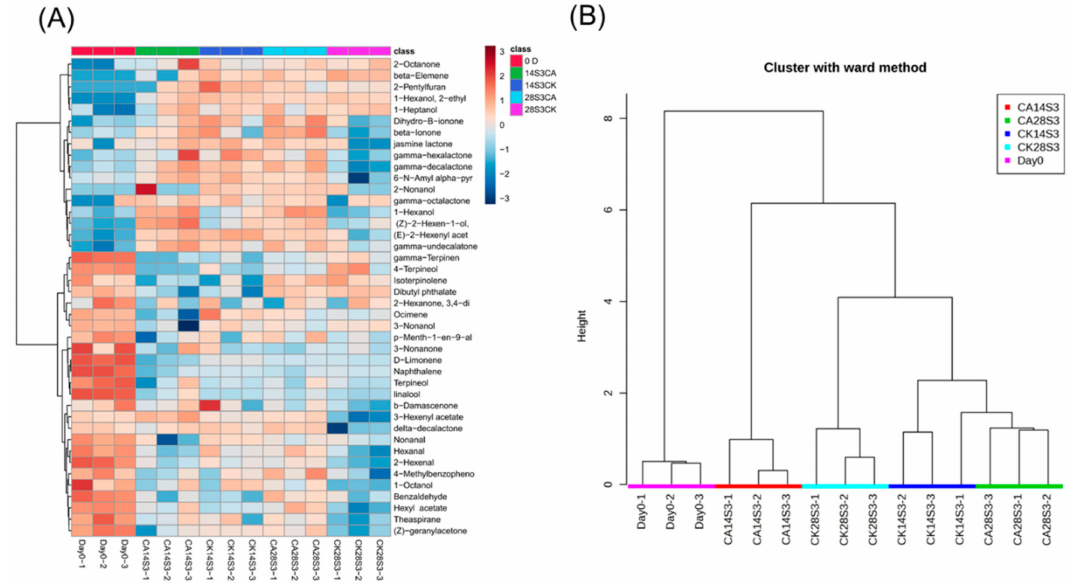
Figure 3. Cluster analysis of peach fruit volatiles during shelf-days after cold storage. ( A ) Heatmap of the peach fruit volatiles; ( B ) Cluster analysis of the peach fruit volatiles. CA28S3-1: the second number represents days after postharvest storage, S, means shelf-life, 3 means the days during shelf-life, the last number means the